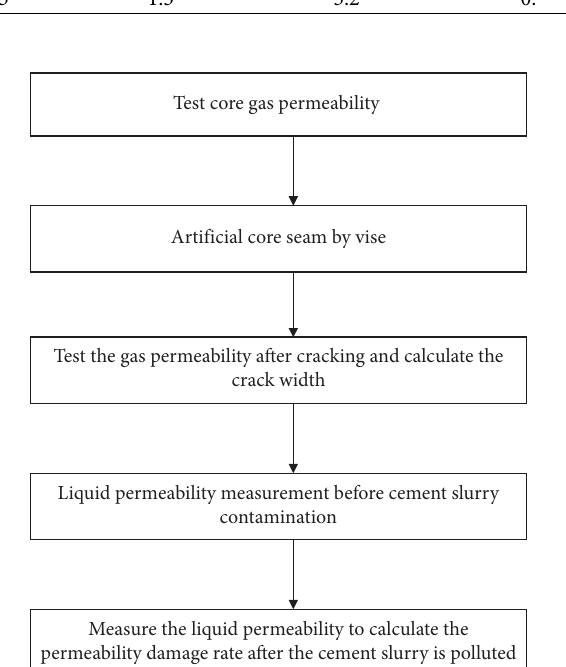
Figure 1: Dynamic experiment fow of cement slurry with green synthesis and metal oxide